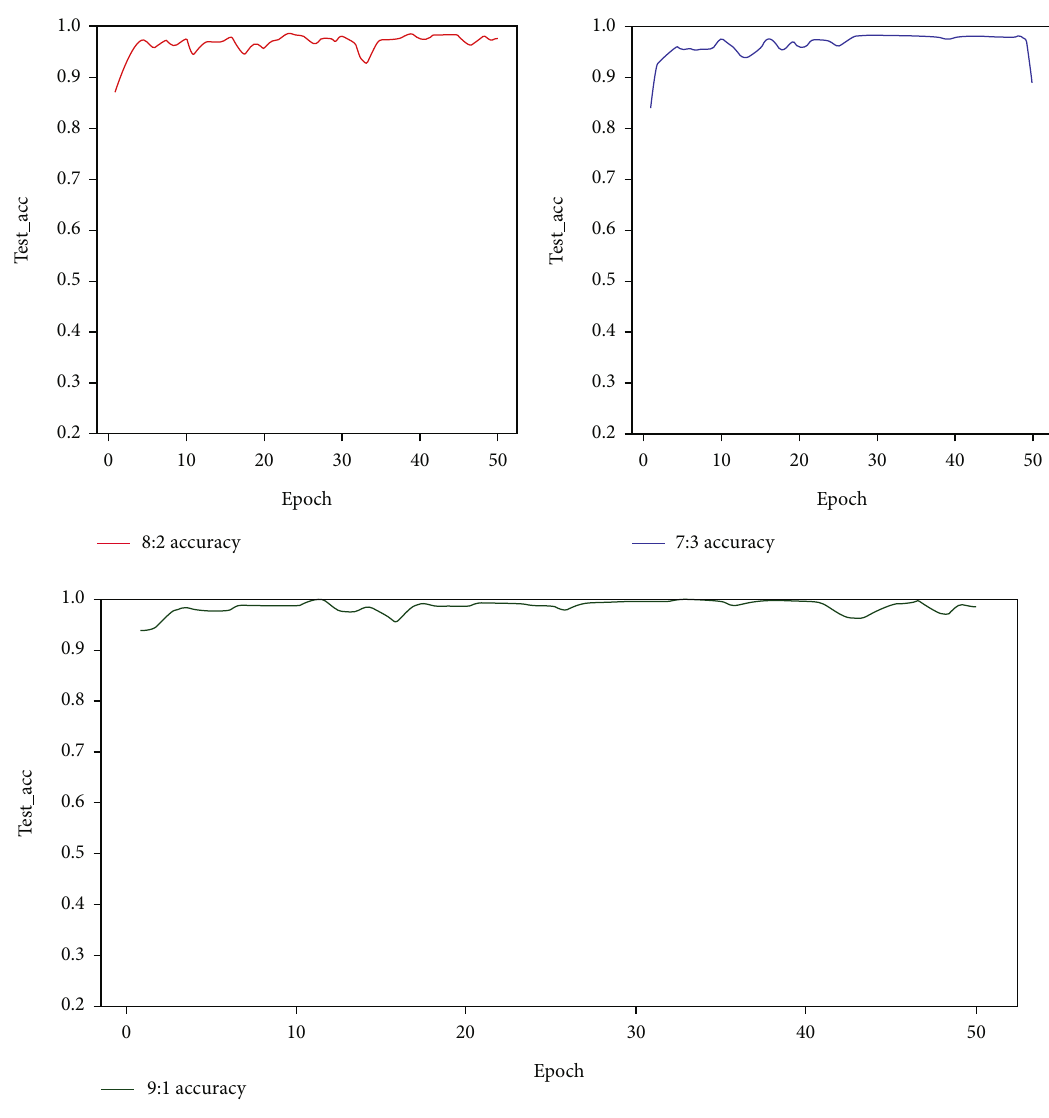
Figure 6: The recognition rate of test set. Table 3: Prediction and identi fi cation results of di ff erent